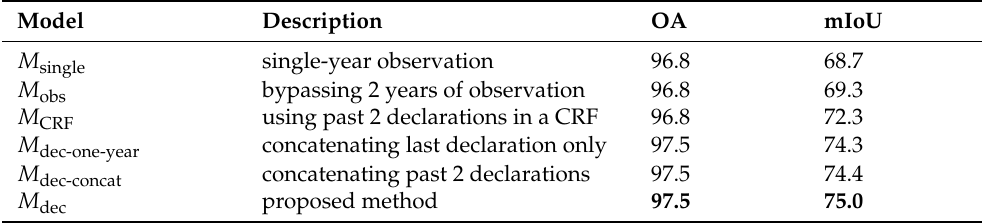
Table 3. Performance by model. Performances (mIoU and OA) of the models M single , M obs , M CRF , and M dec tested for the year 2020. Our proposed model M dec achieve higher performance than M single with a 6.3% mIoU